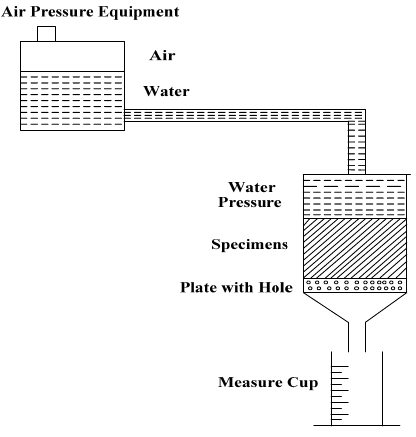
Figure 2. Schematic of the permeability test device.